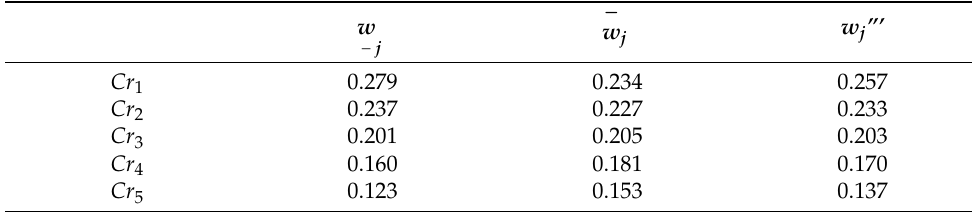
Table 5. The criteria weight obtained based on grey ratings.